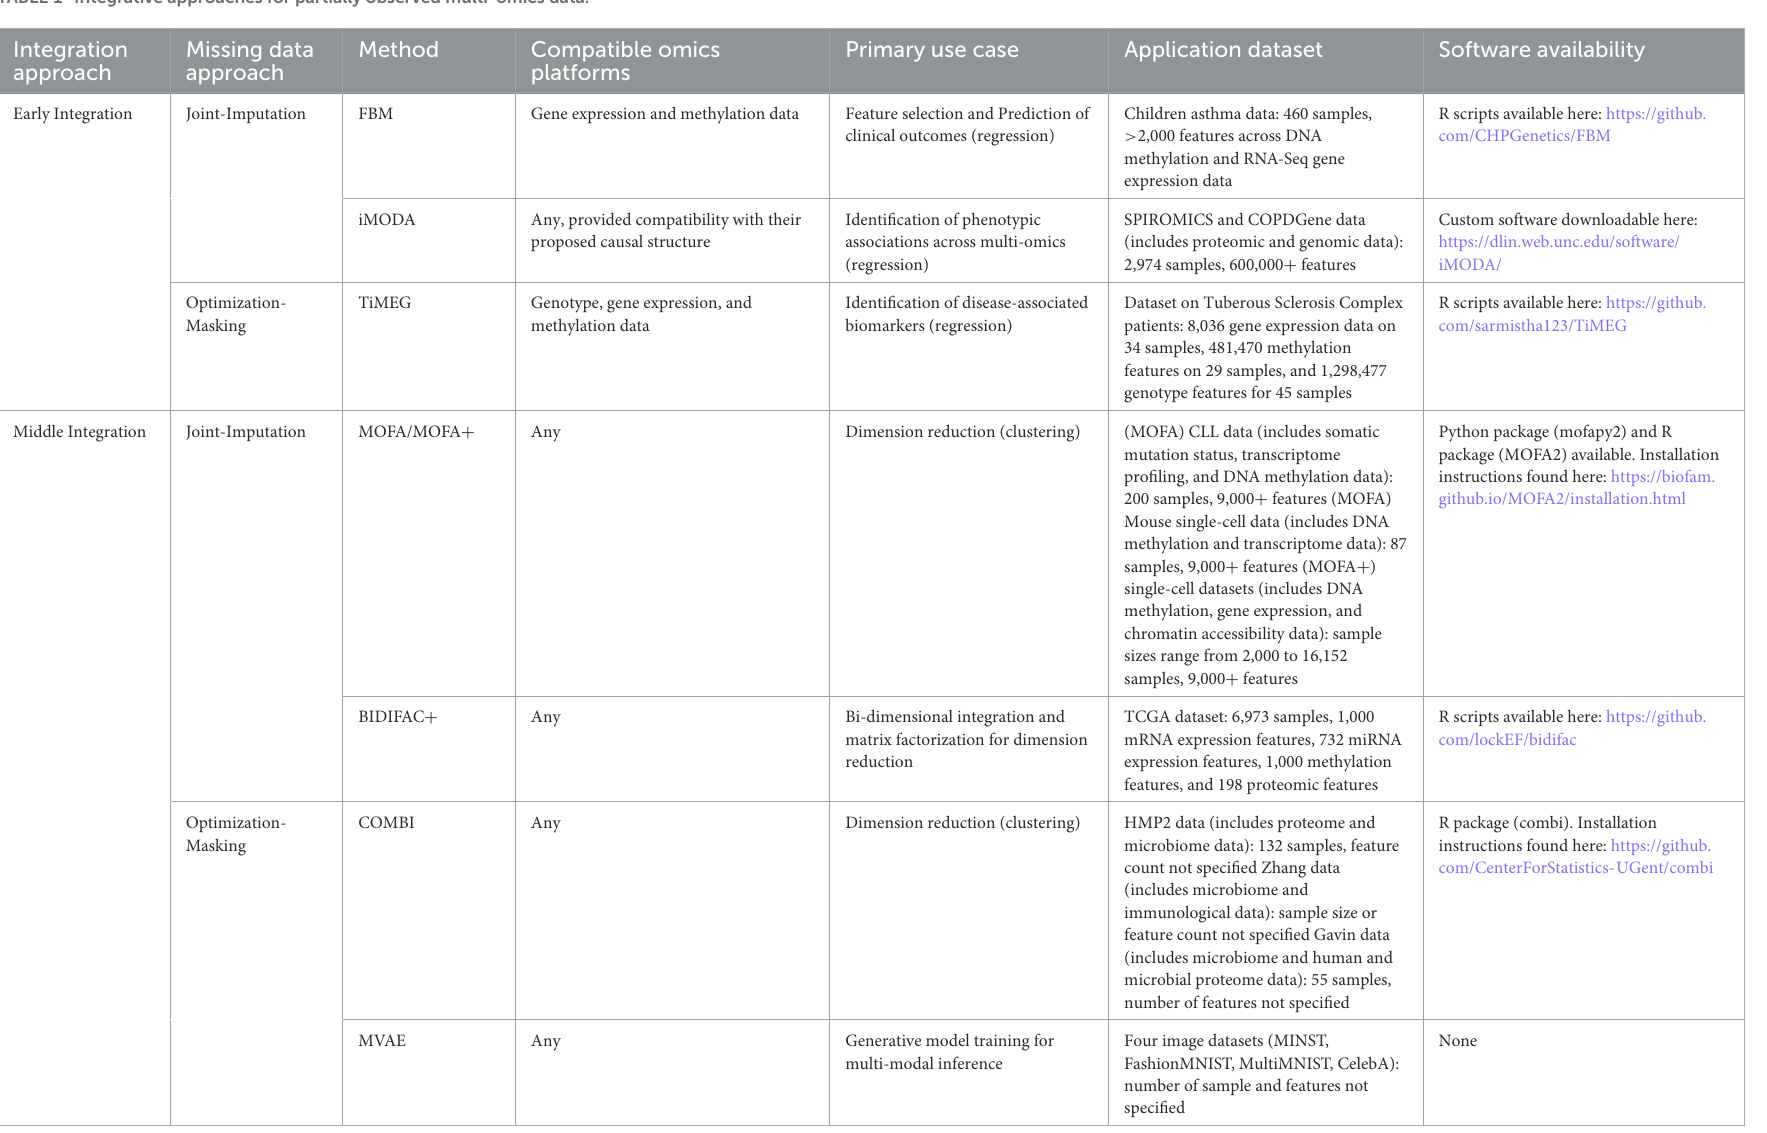
TABLE 1 Integrative approaches for partially observed multi-omics